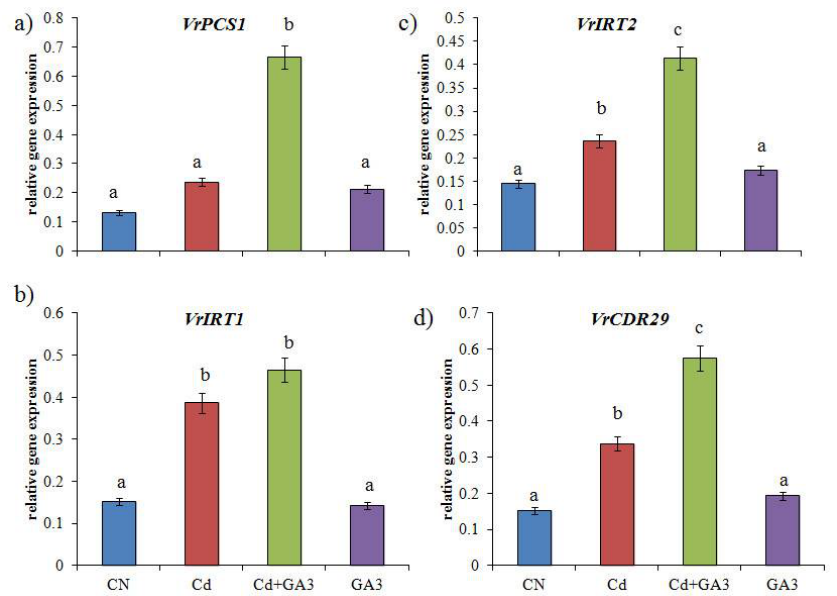
Figure 5. Effect of GA 3 on the relative gene expression of Vigna radiata phytochelatin synthase 1 ( VrPCS1 ), ( a ), VrIron transporter 1 ( VrIRT1 ) ( b ), VrIron transporter 2 ( VrIRT2 ) ( c ) and Vr cadmium response ( VrCDR29 ) ( d ) in young seedlings subjected to Control (CN), cadmium (Cd) stress, Cd+ gibberellins (GA 3 ), and GA 3 alone conditions in paper roll method. Data presented are means ± standard errors ( n = 3, biological replicates). Different letters (a, b, c) indicate significant differences from control in all combinations (Tukey’s test, p ≤